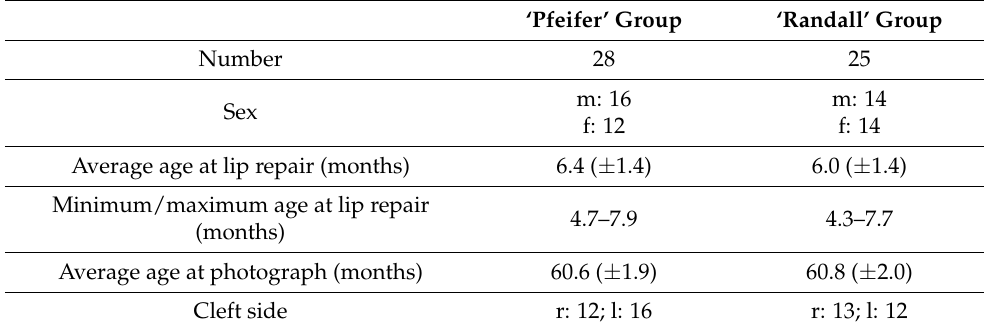
Table 1. To show the demographics of the study cohort. (m: male; f: female; r: right; l: left). ‘Pfeifer’